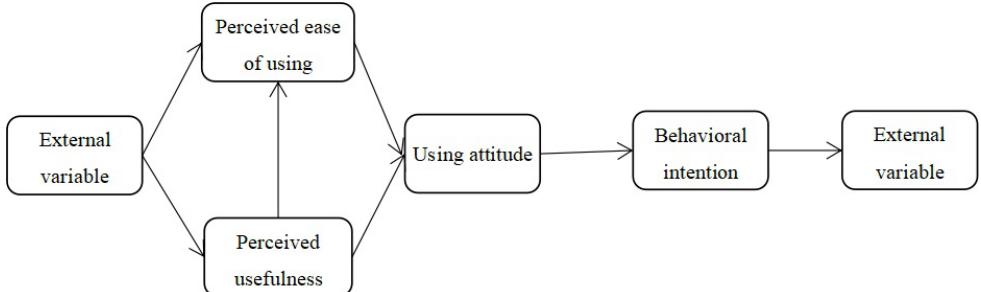
Fig. 3 The Accepting technical